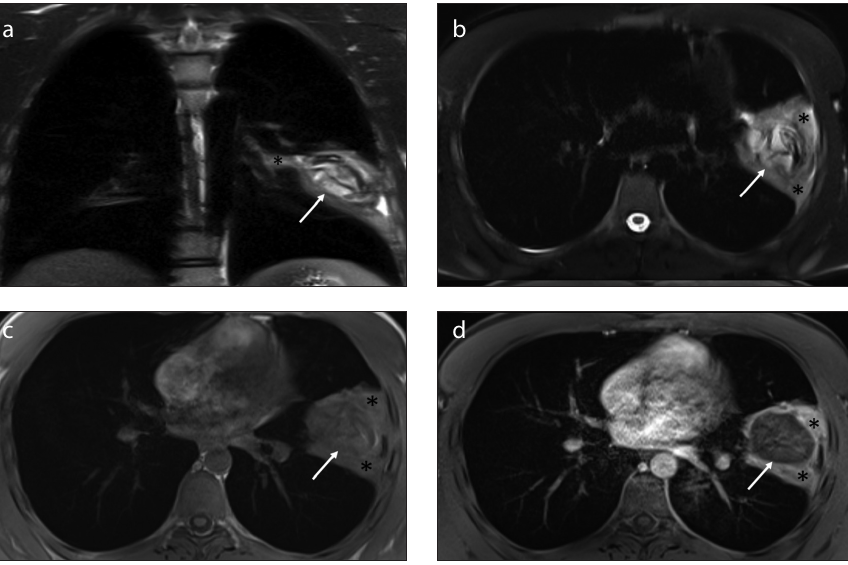
Figure 1. a-d. A 13-year-old female with a bronchogenic cyst in the right upper lobe. Axial T2- weighted fat-suppressed image (a) reveals a hyperintense bronchogenic cyst (black asterisk). Axial T1- weighted image (b) reveals a hypointense bronchogenic cyst (black asterisk). Axial diffusion-weighted (ADC map) image (c) exhibits no diffusion restriction (black asterisk). Axial postcontrast enhanced T1-weighted image (d) exhibits no contrast enhancement (black asterisk).